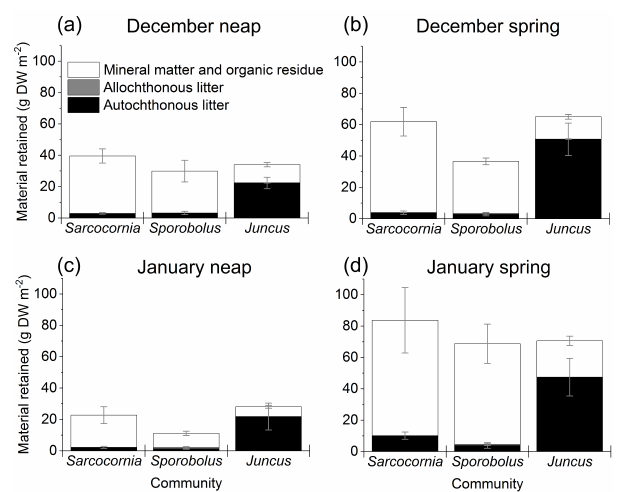
Figure 3. Mean mass of autochthonous litter, allochthonous litter and mineral matter–organic residue retained on filters at the end of a 6-day deployment during December neap (a) , December spring (b) , January neap (c) and January spring (d) tidal periods. Error bars are presented for each component and represent 1 standard error each side of the